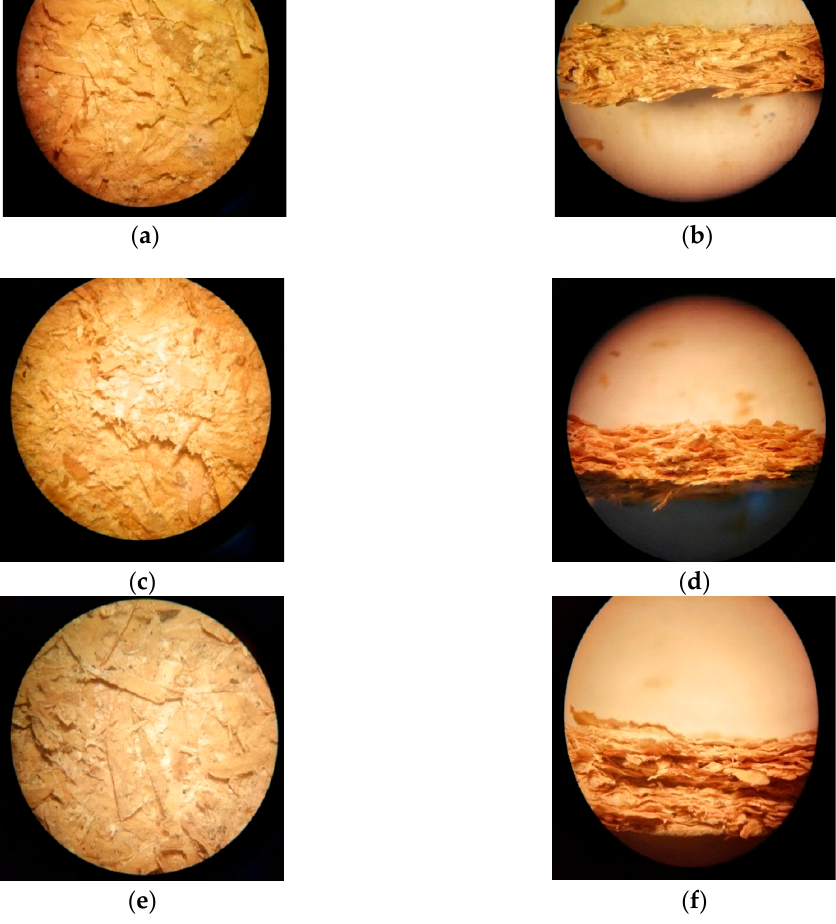
Figure 11. Microscopes for briquettes type ( a ) code AIL in briquette cross section, ( b ) AIL in briquette longitudinal section; ( c ) AIIIL in briquette cross section, ( d ) AIIIL in briquette longitudinal section; ( e ) CIIIH in briquette cross section; ( f ) CIIIH in briquette longitudinal section.